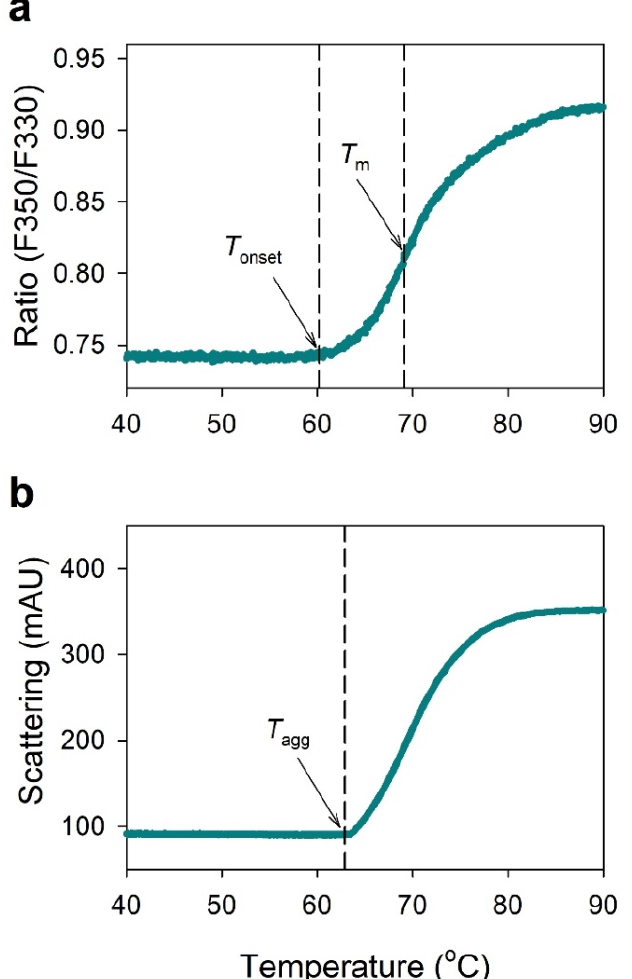
Figure 1. ( a ) Typical nanoDSF thermogram showing the fluorescence intensity ratio at 330 nm and 350 nm; ( b ) Light scattering thermogram by measuring the attenuation of the backreflected light intensity passing through the sample as a function of temperature. The sample was IgG at a concentration of 10 mg/mL in the 50 mM sodium phosphate buffer at pH 7.4. T onset —onset temperature of thermal unfolding; T m —inflection temperature of thermal unfolding; T agg —onset temperature of protein aggregation.